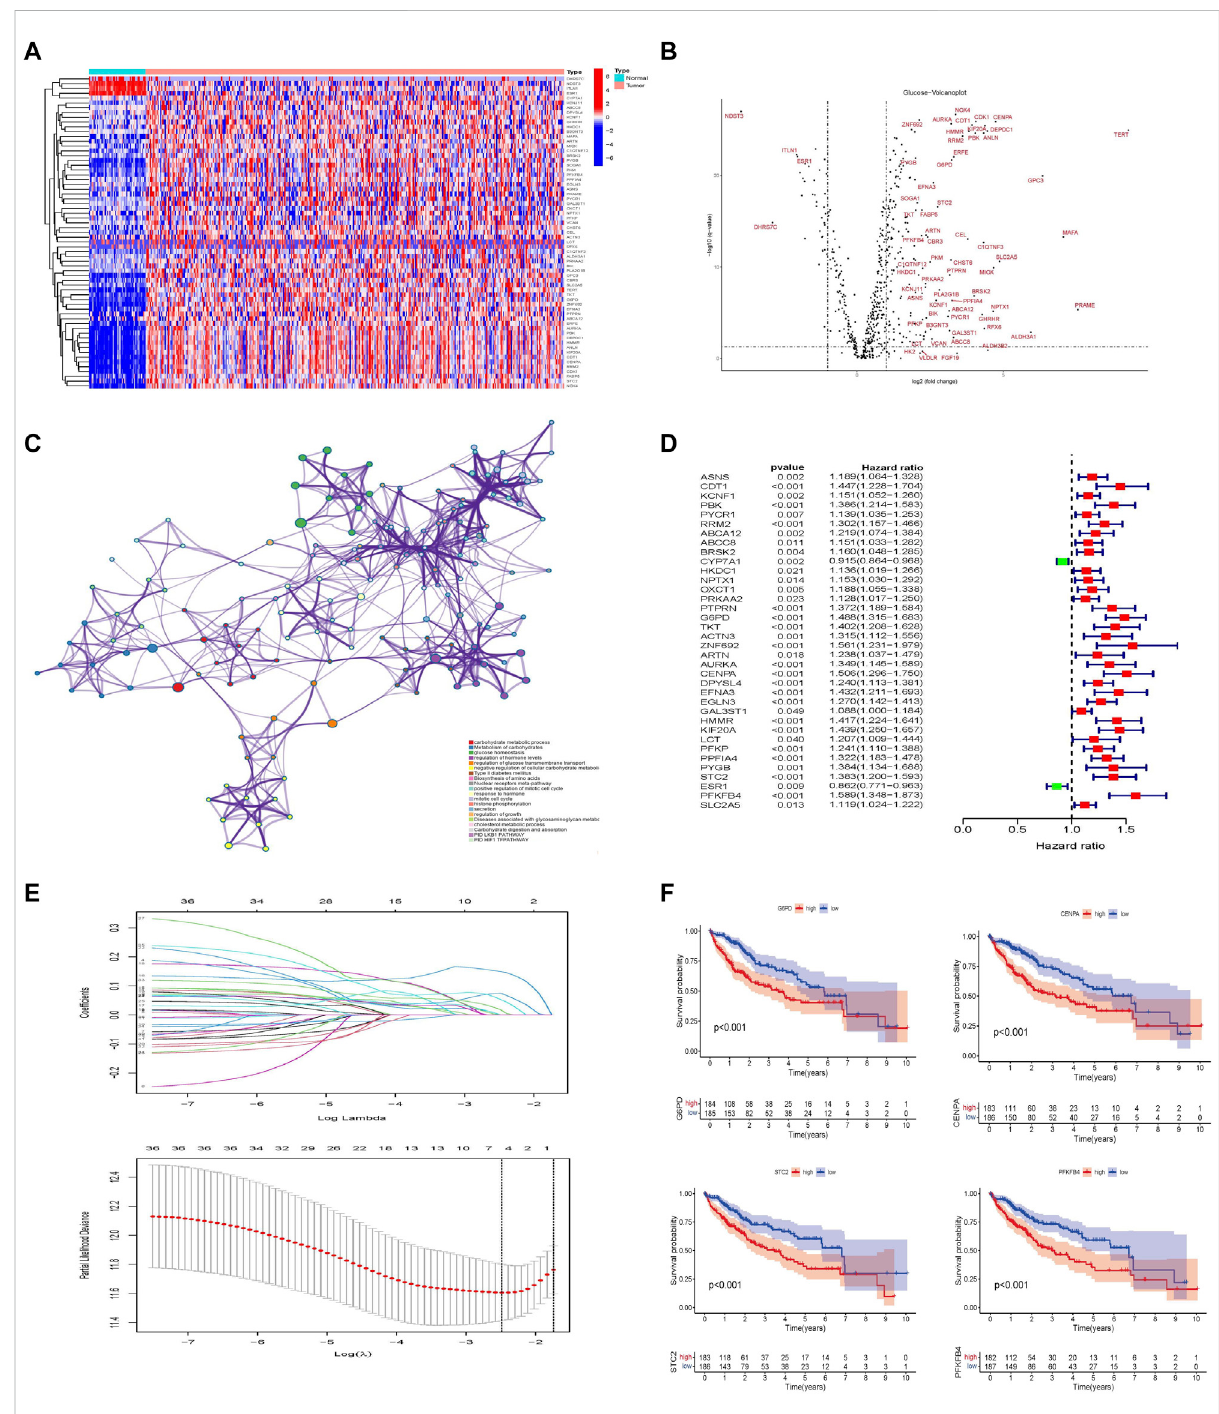
FIGURE 2 Establishment of glycometabolism-related hub genes in hepatocellular carcinoma. (A) Heatmap analysis of differentially expressed genes related to glycometabolism in the TCGA-LIHC cohort. (B) Volcano plot of the differentially expressed genes related to glycometabolism between tumor and normal tissues of HCC (|log2fc| > 2 and FDR < 0.05). (C) Metascape analysis of pathway enrichment of differentially expressed genes relatedtoglycometabolism. (D) UnivariateCoxanalysisof36differentiallyexpressedgenesrelatedtoglycometabolism. (E) LASSOregressionto constructthehubgeneoftheprognosticriskscoringmodel. (F) Kaplan – Meiercurveanalysisoftheeffectoffourhubgenesontheoverallsurvivalof patients with